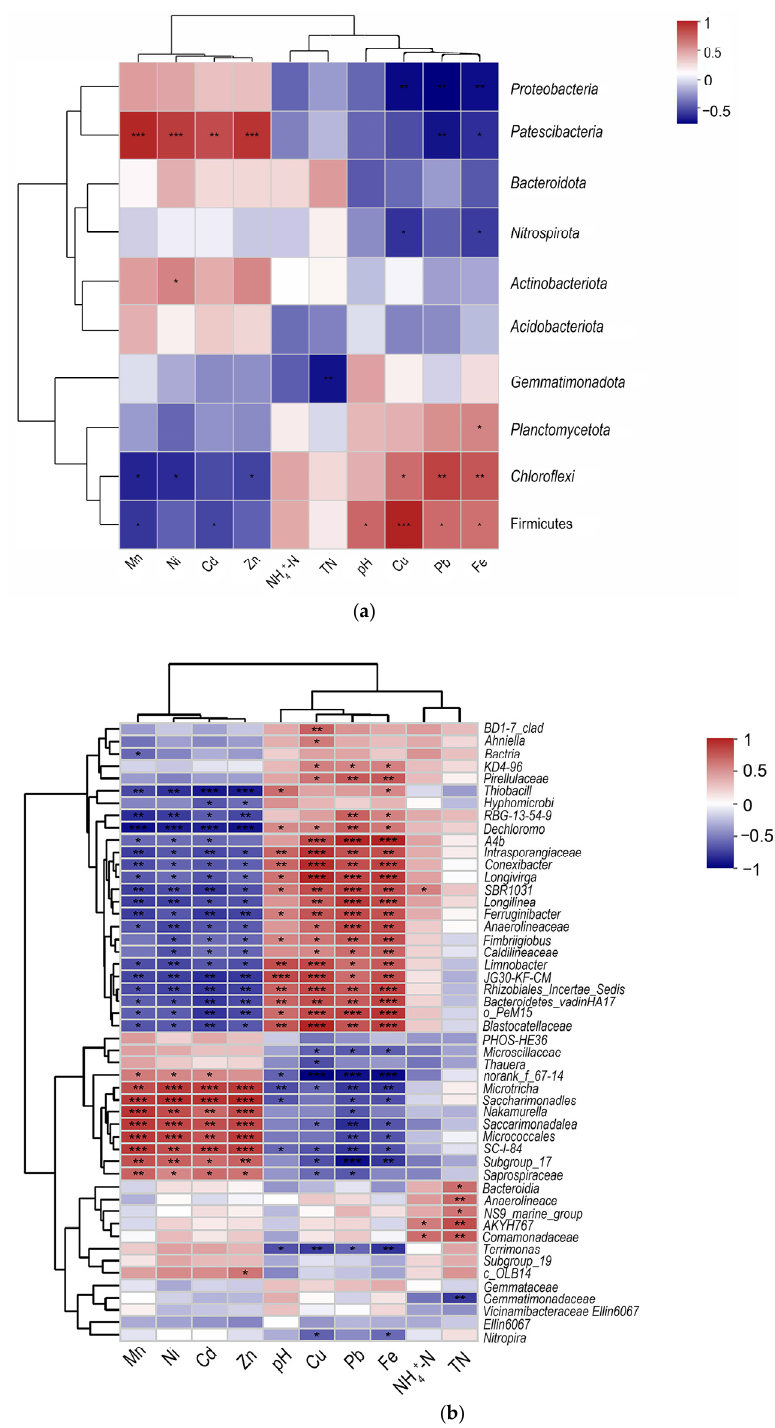
Figure 3. Spearman correlation heatmap of the studied environmental factors, showing the abundance of the dominant bacterial communities in the wastewater treatment plants: ( a ) phylum level; ( b ) genus level. Note: * 0.01 < p < 0.05; ** 0.001 < p < 0.01; *** p < 0.001.